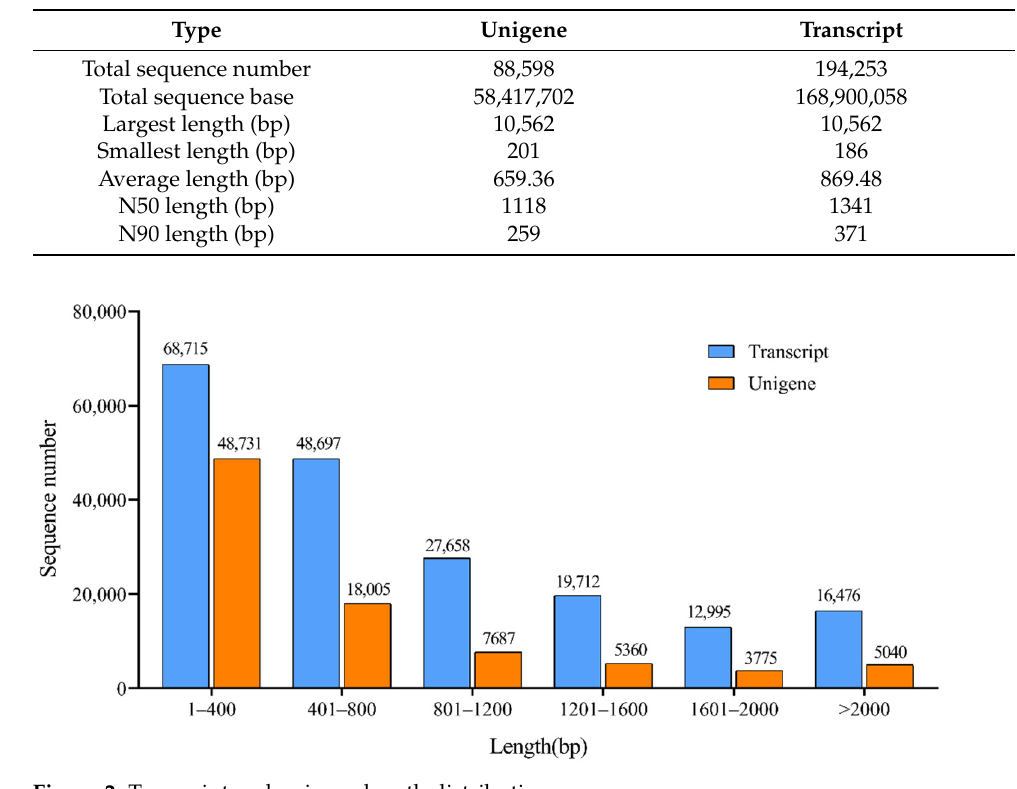
Table 3. Annotation statistics of T. mongolicum